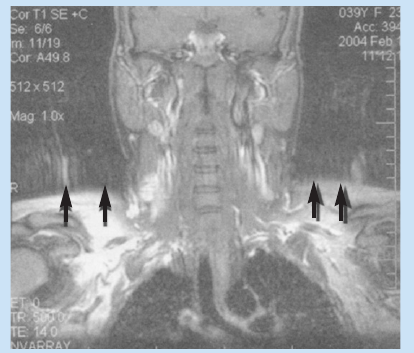
Fig. 1. Motion artefact (T1 coronal study of lumbar